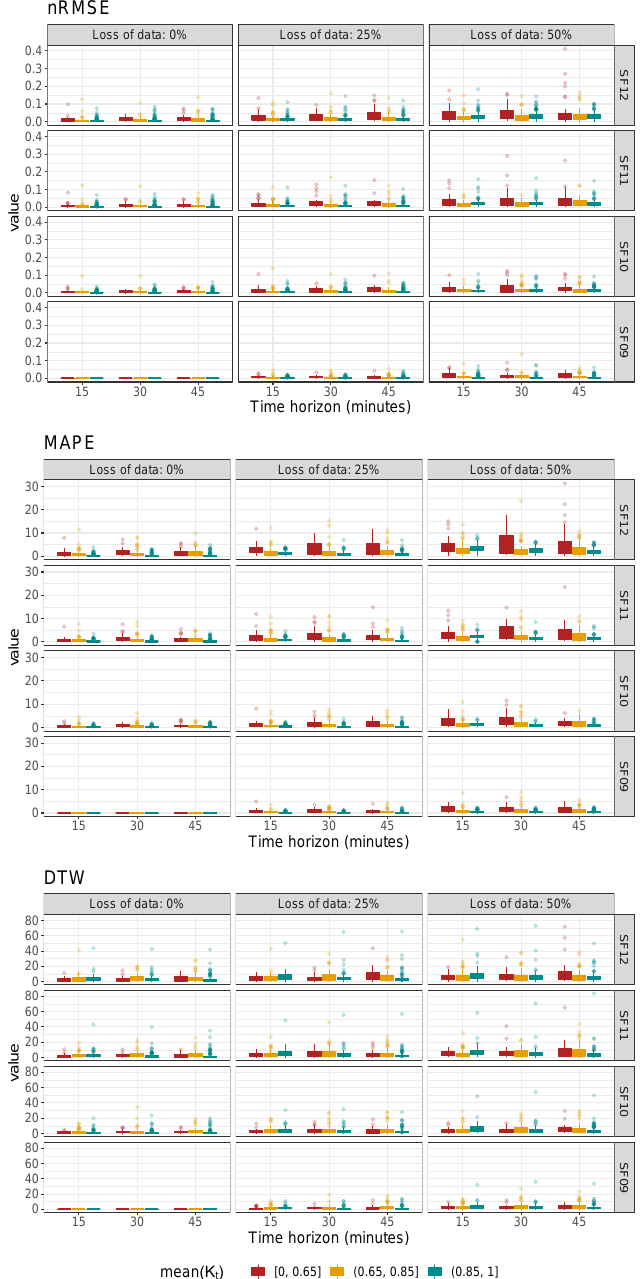
Figure 17. Boxplot of differences based on SF09 and 0% loss of data: nRMSE, MAPE, and DTW metrics for different K t clear sky GHI